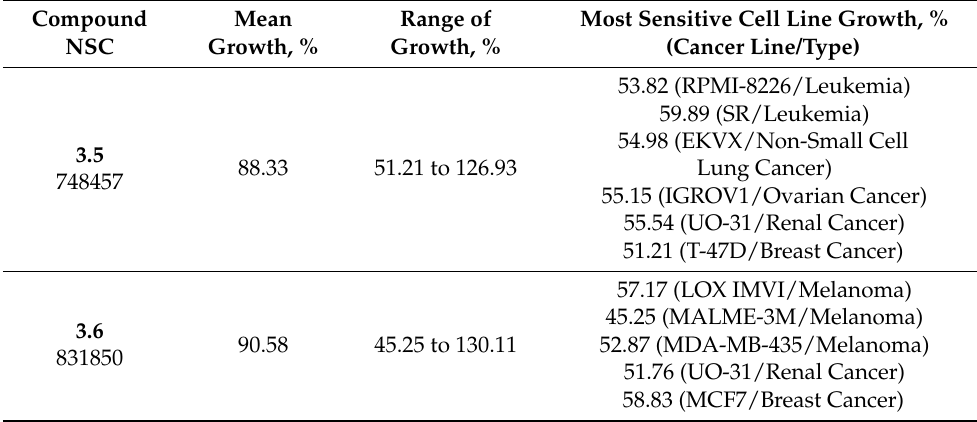
Table 1. Anticancer Screening Data in Concentration of 10 µ